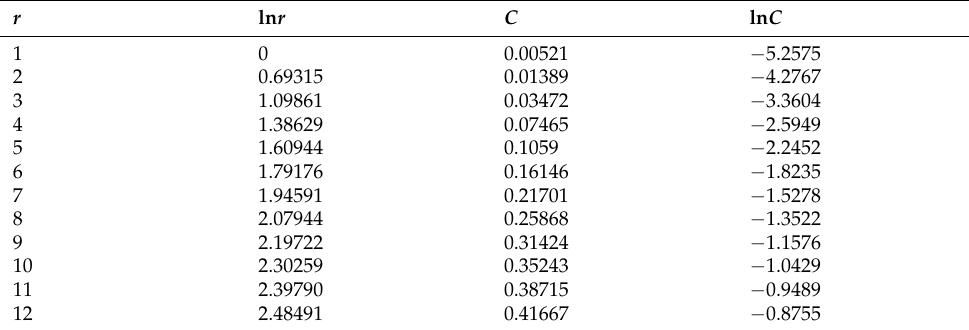
Table A8. Measurements for park system cow correlation dimension.